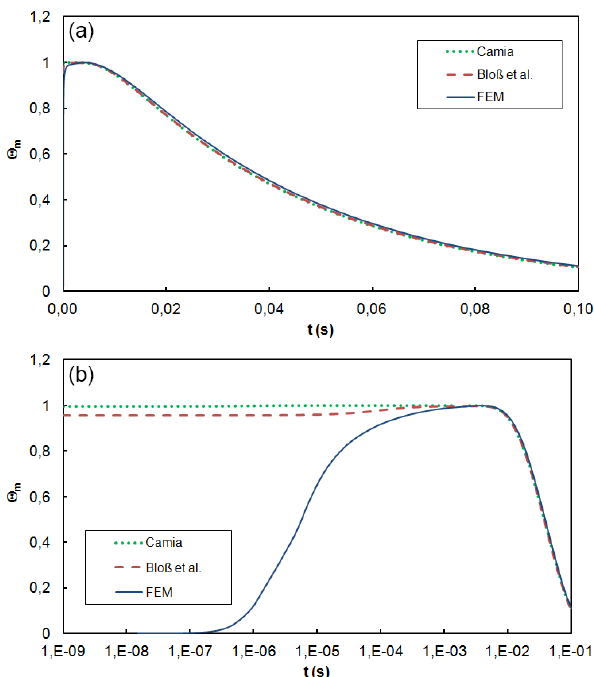
Figure 4. Mean temperature within a PZT plate, determined by three different models (cf. Sect. 2.2) with (a) linear and (b) loga- rithmic time